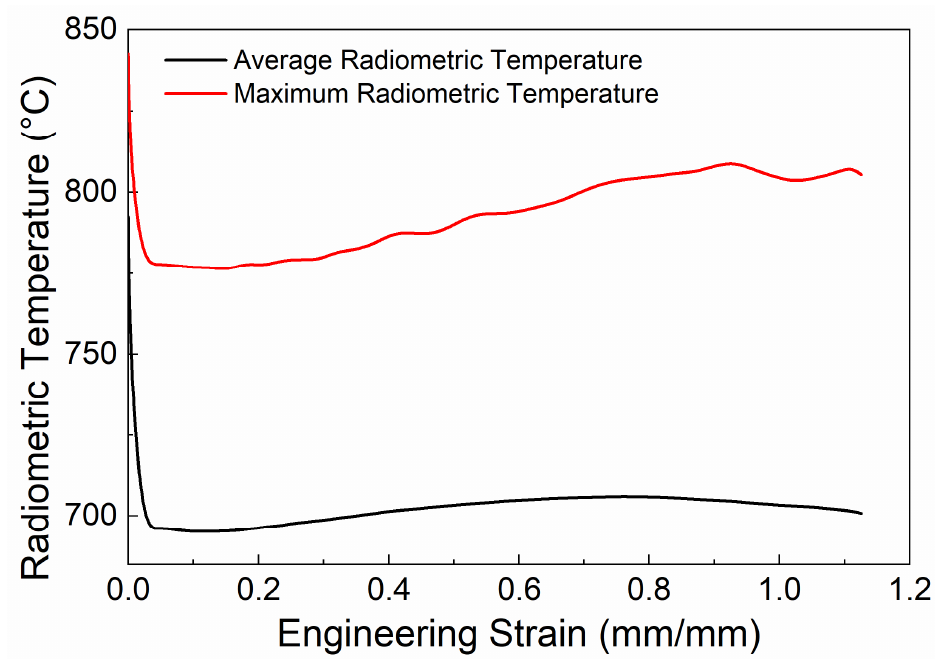
Figure 11. Sharp drop in average and maximum radiometric temperatures observed soon after the onset of plastic deformation.